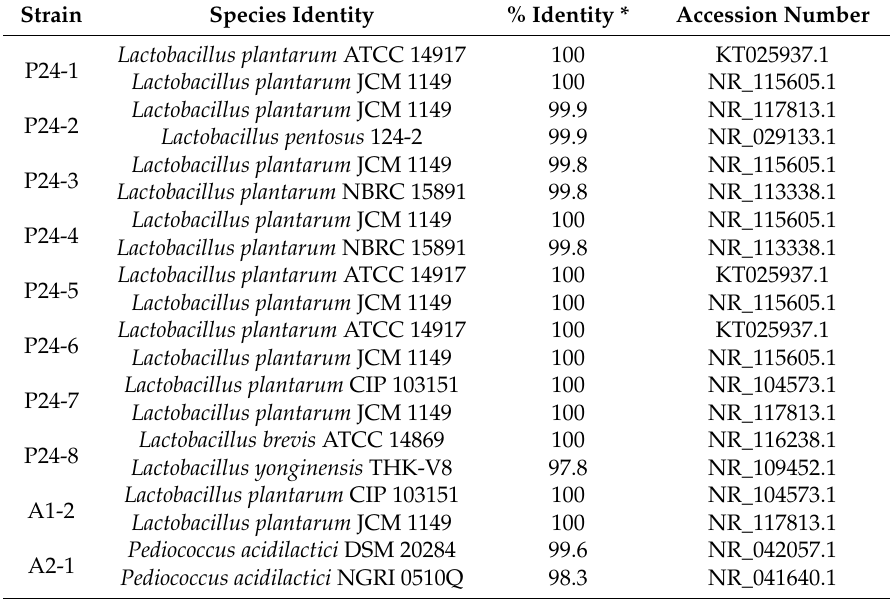
Table 4. Identification of lactic acid bacteria isolates by 16S rRNA